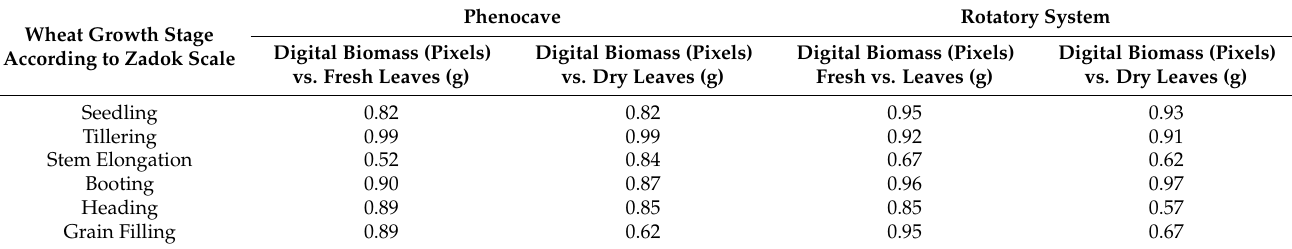
Table 1. Pearson correlation coefficient between digital biomass, fresh weight, and dry weight at different growth stages. Phenocave Rotatory System Wheat Growth Stage Digital Biomass (Pixels) Digital Biomass (Pixels) Digital Biomass (Pixels) Digital Biomass (Pixels) According to Zadok Scale vs. Fresh Leaves (g) vs. Dry Leaves (g) Fresh vs. Leaves (g) vs. Dry Leaves (g) Seedling